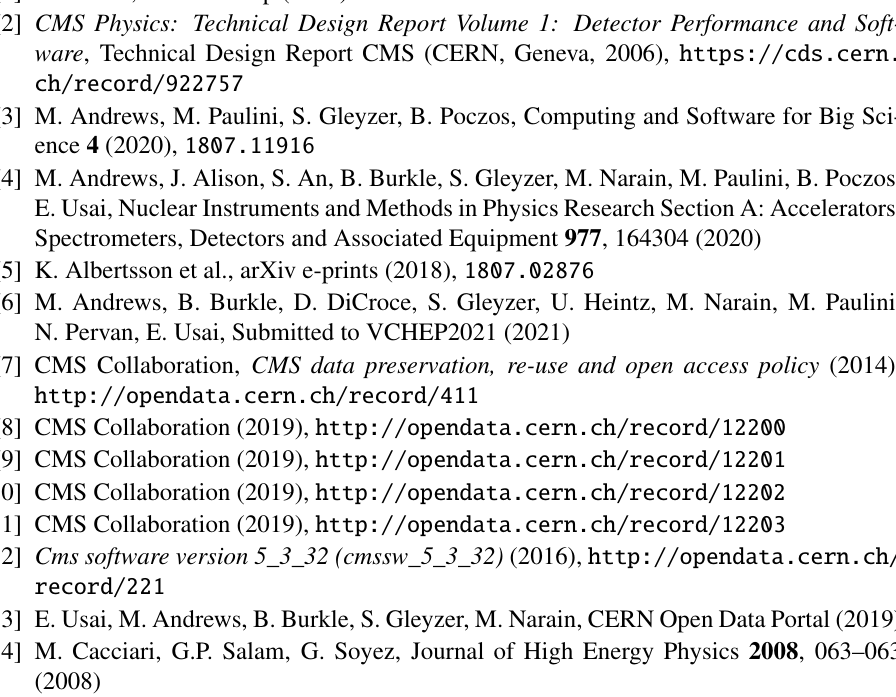
Table 4. I / O and training time comparison for di ff erent